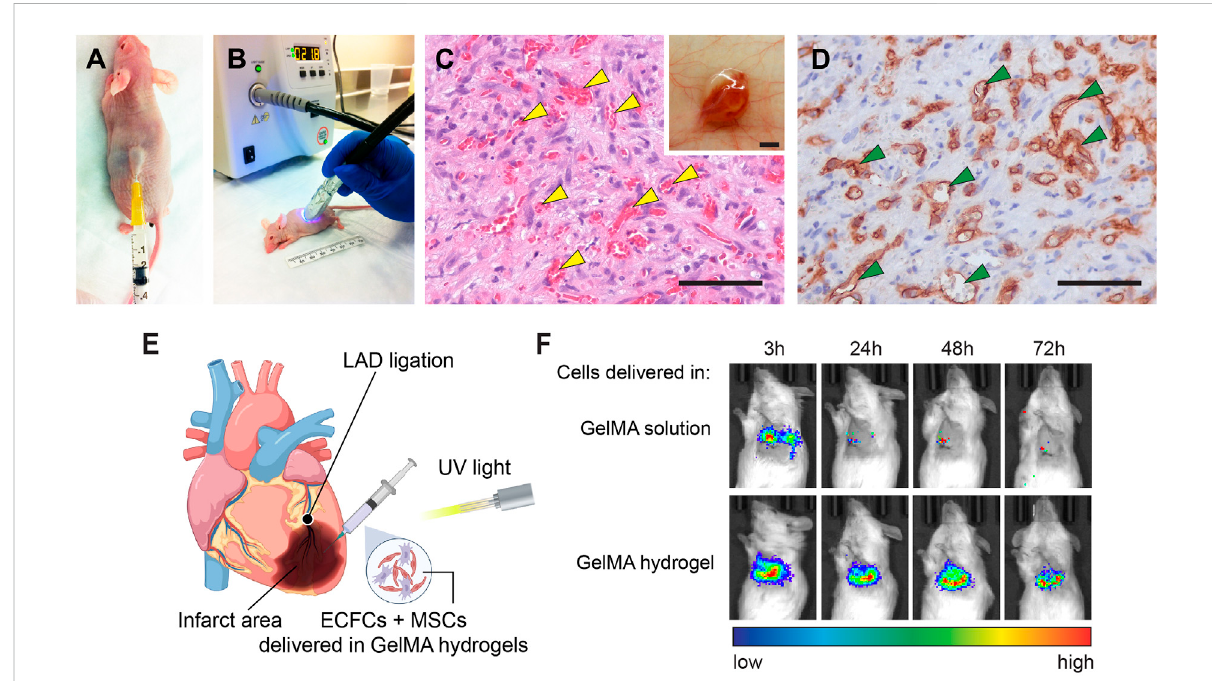
FIGURE 4 Transdermal and intramyocardial photopolymerization of GelMA hydrogels for in vivo vascular network bioengineering. (A) Human ECFCs and MSCswereresuspendedinaGelMAprecursorsolutionandinjectedsubcutaneouslyintonudemice. (B) Representativeimagesofamousereceiving transdermal UV light. (C) Representative H&E-stained section from a day 7 construct that was transdermally polymerized. Yellow arrowheads mark perfused blood vessels. Scale bar, 50 µm. Insert: the vascularized construct in the subcutaneous space after 7 days. Scale bar, 500 µm. (D) Human ECFC-formed vascular networks were identi fi ed by the human-speci fi c CD31 immunohistochemistry. Green arrowheads mark perfused lumens lined by hCD31 + ECFCs. Scale bar, 50 µm (Lin et al., 2013). (E) Schematic depicting the intramyocardial cell injection. Myocardial infarction was surgically induced by left anterior descending artery (LAD) ligation. Human vascular progenitor cells (ECFCs + MSCs) resuspended in GelMA precursor solution were injected and photocrosslinked into a cell-laden hydrogel. (F) Viable cell retention was measured by bioluminescence imaging of human ECFCs expressing a luciferase reporter. The results showed that the GelMA hydrogel signi fi cantly enhanced cell retention in ischemic hearts during the fi rst 72 h (Hong et al.,